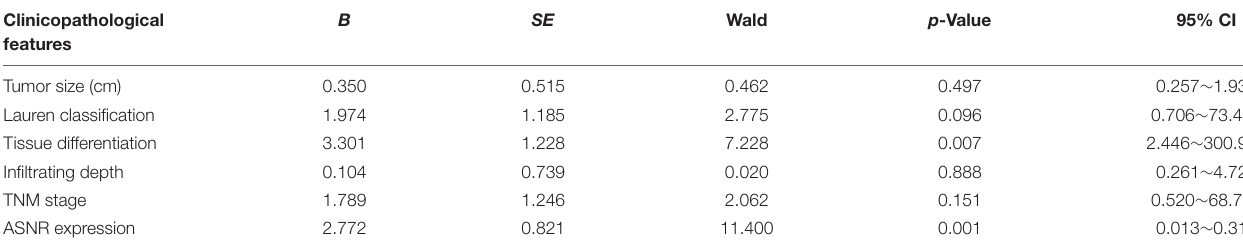
TABLE 3 | Multivariate analysis of prognostic factors in 76 patients with gastric